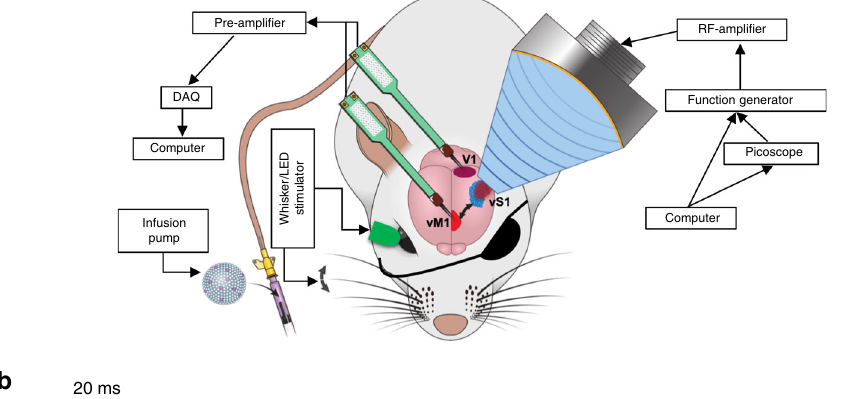
(vS1, “ barrel cortex ” ) 33 . The vS1-vM1 circuit is a good model for in vivo study of FUS-mediated delivery of drugs as vS1 and vM1 are anatomically distant, yet strongly connected brain areas. This allowed us to sonicate vS1 site while doing electrophysiological recordings in vM1 to assess response of drug delivery to vS1,